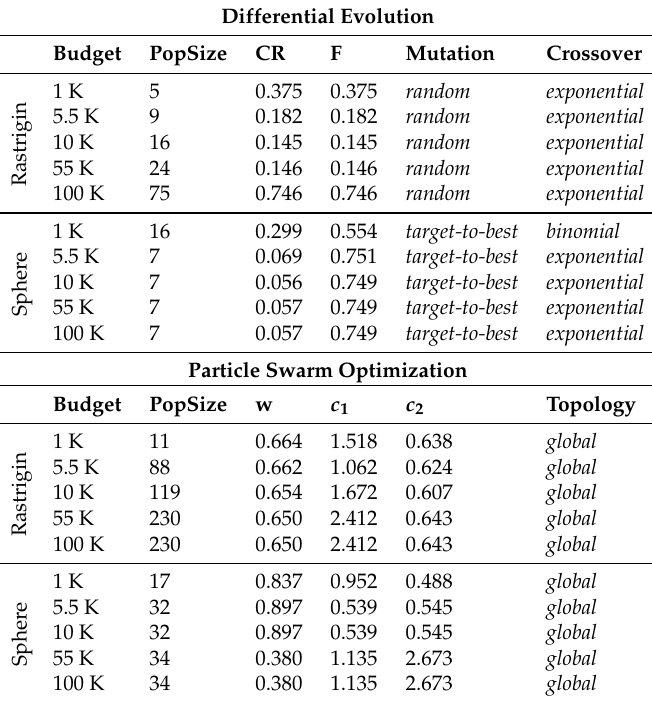
Table 5. DE and PSO configurations obtained by the Flexible-Budget Method [32].